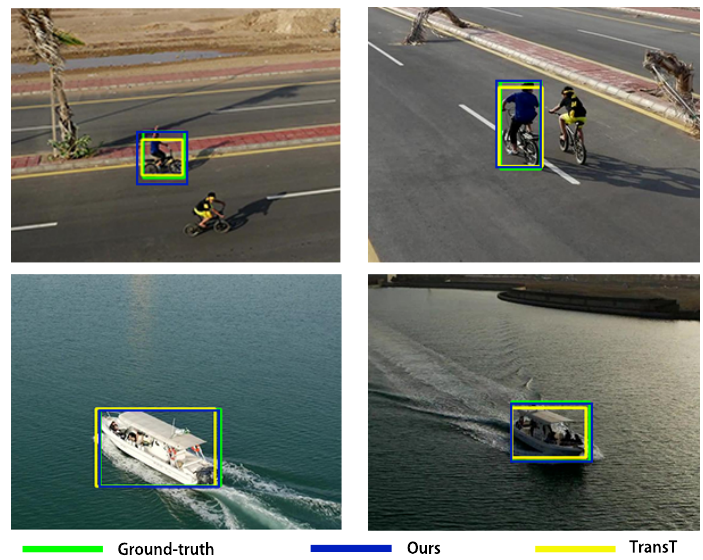
Figure 8. A comparison of our approach with